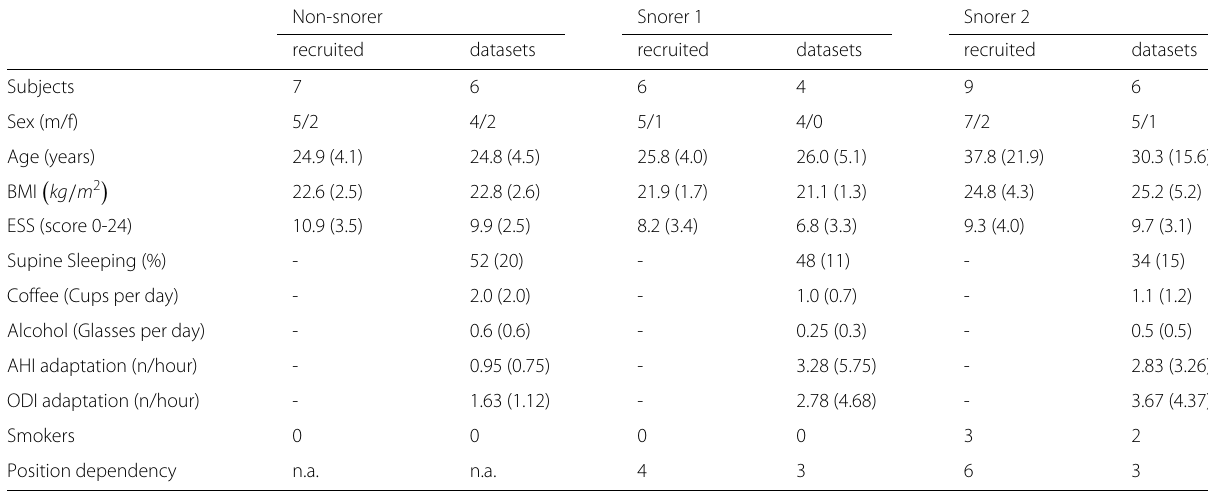
Table 1 Demographics of the study groups. Supine Sleeping was calculated as the percentage of the total time in bed that was spent in supine position. Position dependency was assumed if more than 50% of all snores during the baseline night occurred in supine position. AHI and ODI have been obtained using the automatic scoring provided by the ApneaLink software (purchased from ResMed). Age, BMI, ESS, AHI, and ODI are reported as mean and standard deviation. All other values indicate the number of subjects Non-snorer Snorer